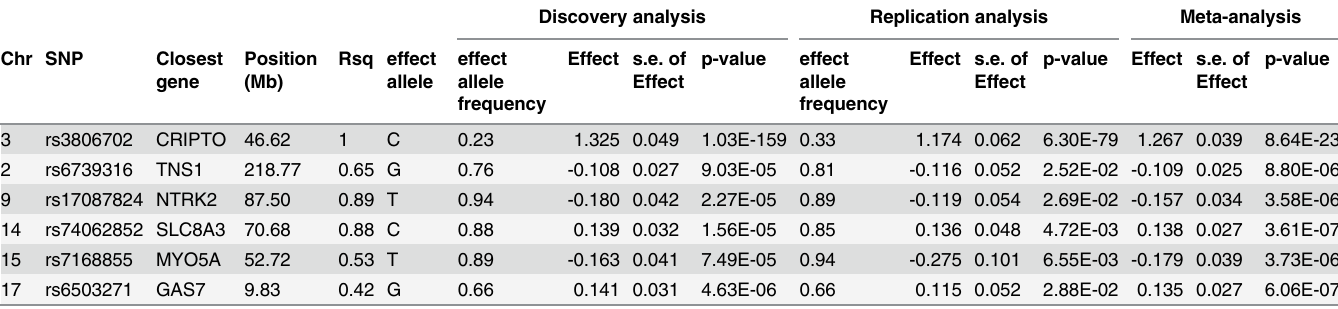
Table 2. Association results of replicated